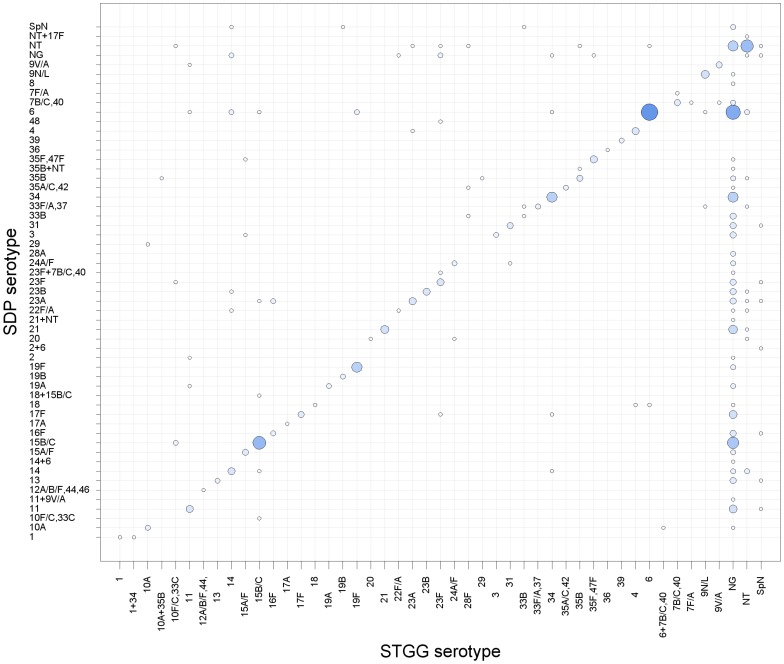
Serogroup/type concordance between the different swab transport methods.The size of data points is proportional to the frequency of isolates. Spn = Streptococcus pneumoniae, NT = nontypeable, NG = no growth.